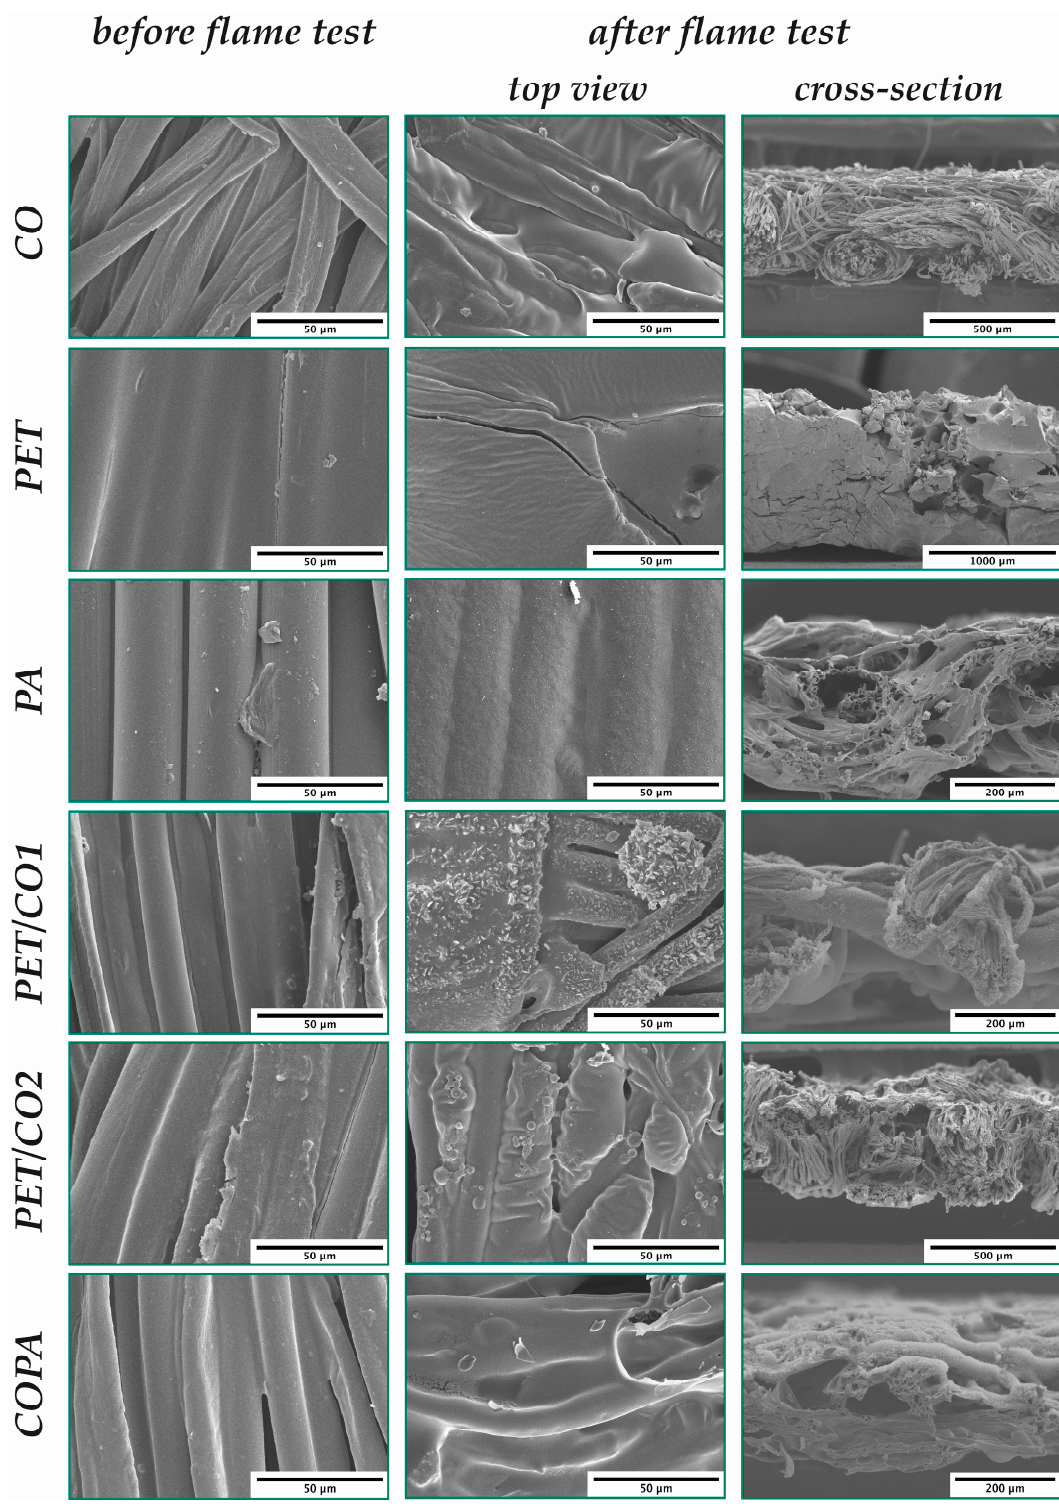
Figure 11. Cross-section SEM images of the charred section of the fabrics.